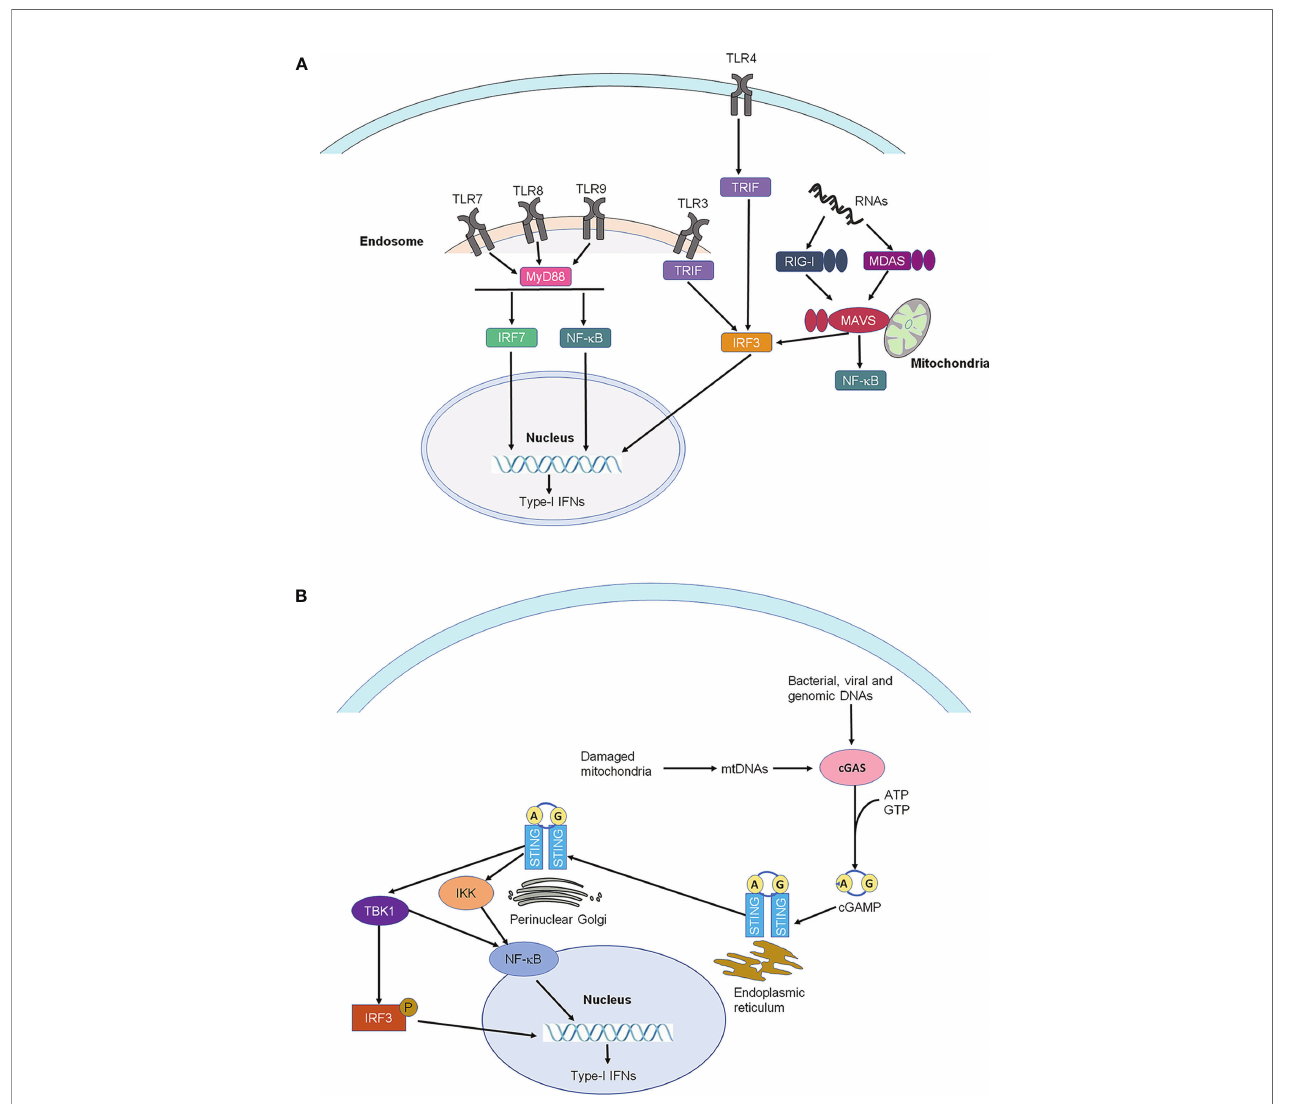
FIGURE 1 | Production of type-I IFNs. (A) Production of type-I IFNs by activation of Toll-like receptors (TLRs) and RIG-I-like receptors (RLRs). Type-I IFNs can be induced by the activation of TLR3, TLR4, and TLR7, TLR8, TLR9 via distinct intracellular signaling molecules, such as TRIF for TLR3 and TLR4, and MYDd88 for TLR7-9. TLRs are the best-known pattern recognition receptors and are localized either on the cell surface or on intracellular compartments such as endosomes (TLR3, TLR7-9) of immune cells and glial cells. (B) Production of type-I IFNs by activation of STING. STING is an endoplasmic reticulum adaptor. Activated by viruses and intracellular DNAs, STING activates TBK1, which subsequently activates the transcription factors NF k B and interferon regulatory factor 3 (IRF3), leading to the production of type-I IFNs. IRF3, interferon regulatory factor 3; IRF7, interferon regulatory factor 7; MAVS, mitochondrial antiviral signaling proteins; MDA5, melanoma differentiation-associated protein 5; MYD88, myeloid differentiation primary response 88; NF- k B, nuclear factor kappa-light-chain-enhancer of activated B cells; RIG- 1, retinoic acid-inducible gene; STING, stimulator of interferon genes; TBK1, TANK-binding kinase 1; TRIF, TIR-domain-containing adapter-inducing IFN- b